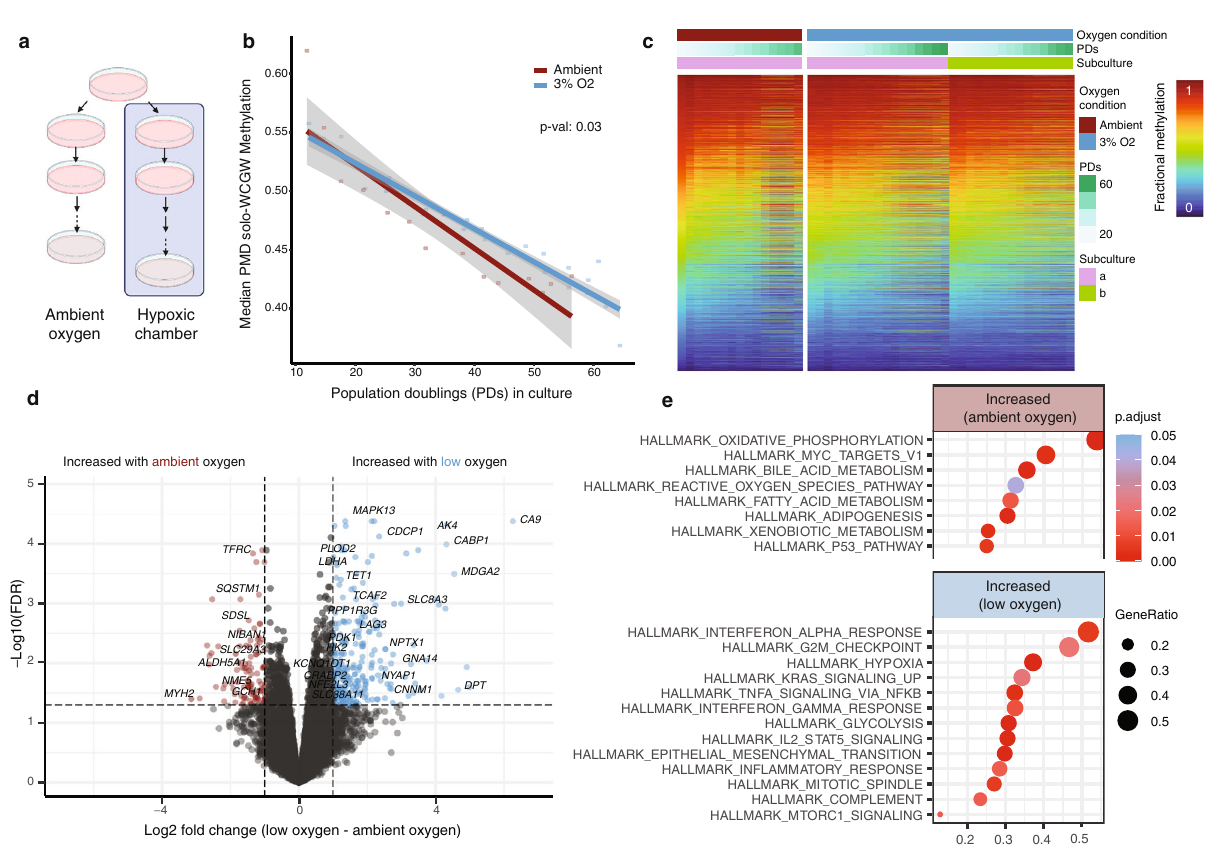
Fig. 2 | Meaningful groupwise PMD solo-WCGW behaviors. a PMD solo-WCGWs wereseparatedintomajorcategories:(fromtop)stablyhypermethylated,variable, and stably hypomethylated. Representative primary cell AG06561 (fetal skin fi broblast) is depicted. Left, methylation heatmap of CpGs (rows) within each category. Samples (columns) are ordered by advancing population doublings (PDs). Right, density plot of probes within each major category, with the variable group further split into quartiles by starting methylation. b Median PMD solo- WCGW methylation for TERT -immortalized and control primary fi broblasts through replicative senescence for control fi broblasts (pink-shaded region) and through late PDs for immortalized fi broblasts (blue-shaded region). c RedistributionofPMDsolo-WCGWsatearly,non-immortalizedpassage,late,non- immortalized passage, and late, TERT -immortalized passage. d PMD solo-WCGWs in TERT -immortalized fi broblastsweregroupedbysameparadigminpanel a .Locus overlap enrichment analysis was performed on each group, with all PMD solo- WCGWs on array as background. e PMD solo-WCGW methylation change per population doubling (PD) for neonatal foreskin fi broblast 2 (AG21859) binned